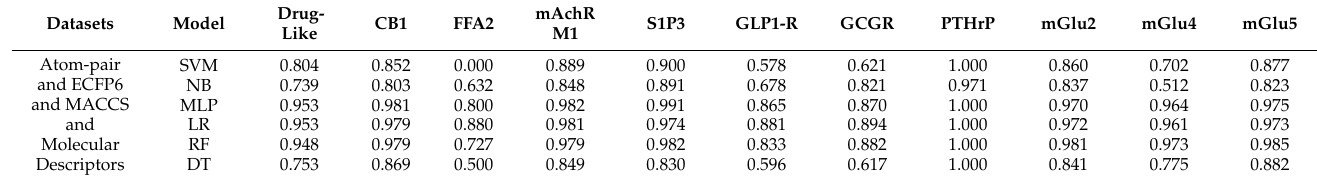
Table 8. The f 1 -score of the Test Set on Dataset with Four Feature Types on Each GPCR Class.